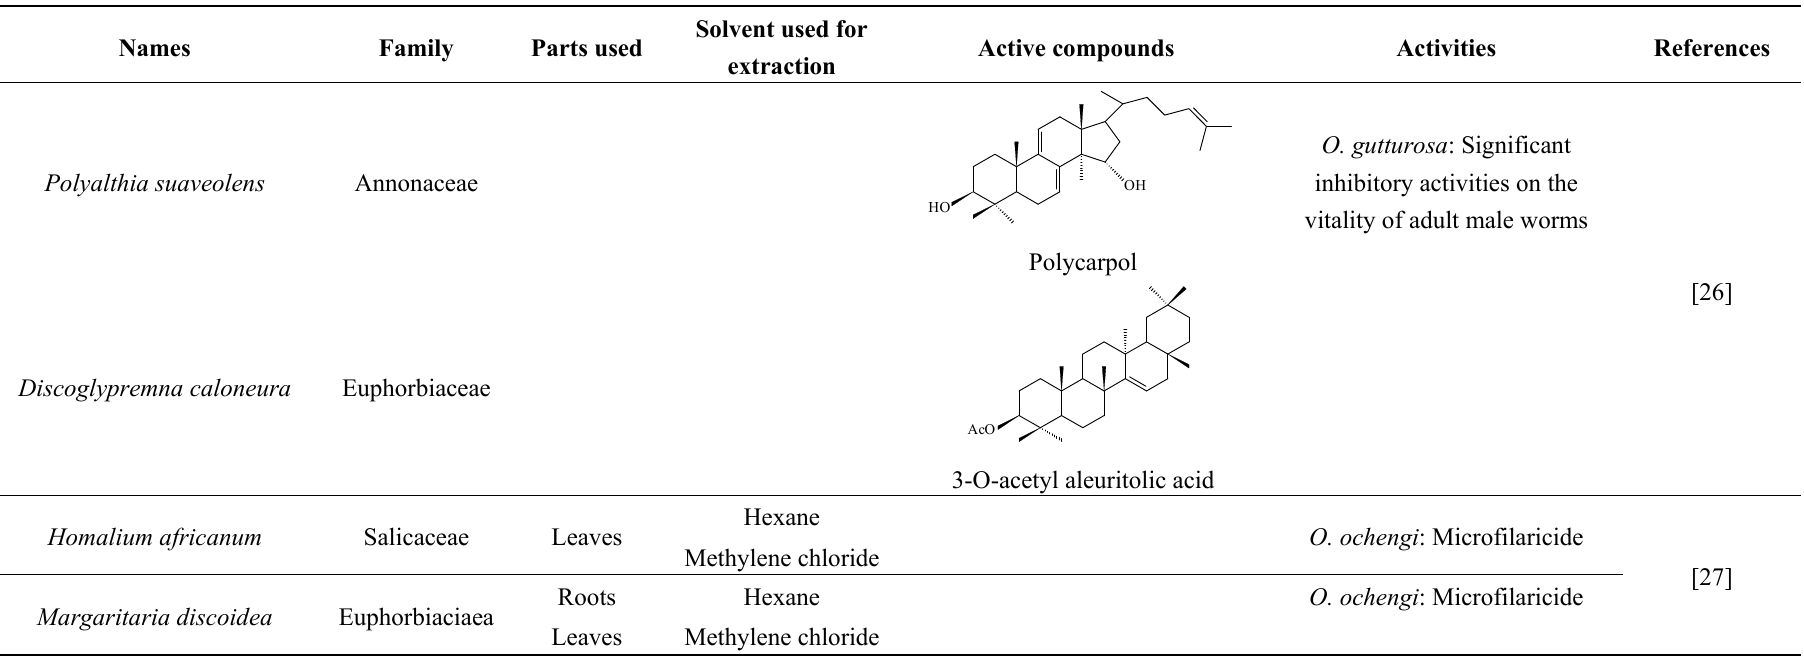
Table 1. List of medicinal plants, products and active compounds known to have antifilarial